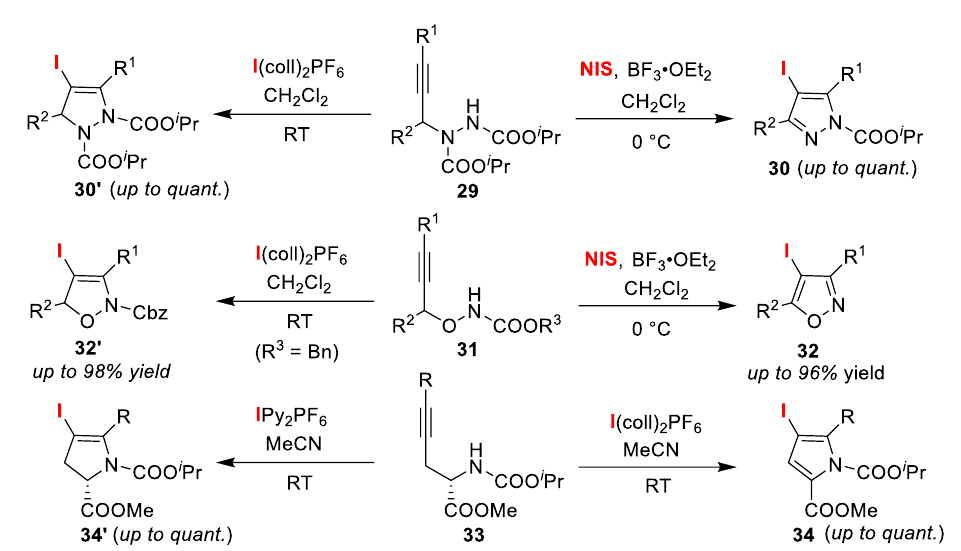
Figure 17. Plausible reaction mechanism of the iodo-cyclizations of alkynyl carbamates ( 29 , 31 , and 33 ). Gao and co-workers achieved the base-dependent selective synthesis of oxazoles 36 and oxazolines 3 6′ via the oxidative cyclization of β -acylamino ketones 35 in the presence of an iodine catalyst [63]. When K 2 CO 3 was used as a base, oxazolines 3 6′ , in the form of enes, were produced. In contrast, treatment with 1,8-diazabicyclo[5.4.0]undec-7-ene (DBU) instead of K 2 CO 3 led to the formation of oxazoles 36 , in the form of aromatics. The authors proposed a reaction mechanism in which the active high-valent iodine species, [IO] − I + generated from tert -butyl hydroperoxide (TBHP), and I 2 under basic conditions, was introduced to the substrates, triggering intramolecular nucleophilic substitution (Figure 18). The O -cyclization reaction at the amide moiety, thus, gave oxazoline products 3 6′ . In addition, the authors explained that DBU promotes further iodination and subsequent deiodination for the production of oxazoles 36 .